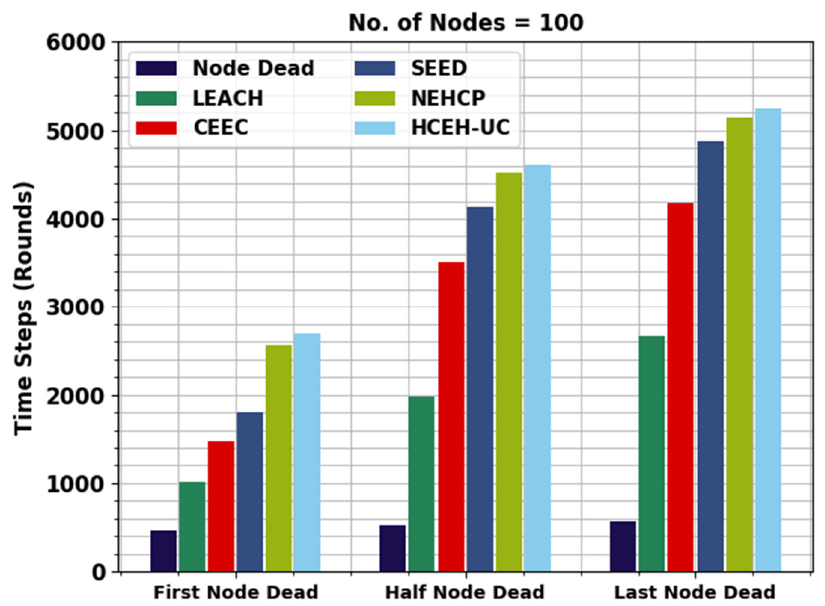
Figure 3. Lifetime analysis of WMAO-EAR approach under NC of 100.